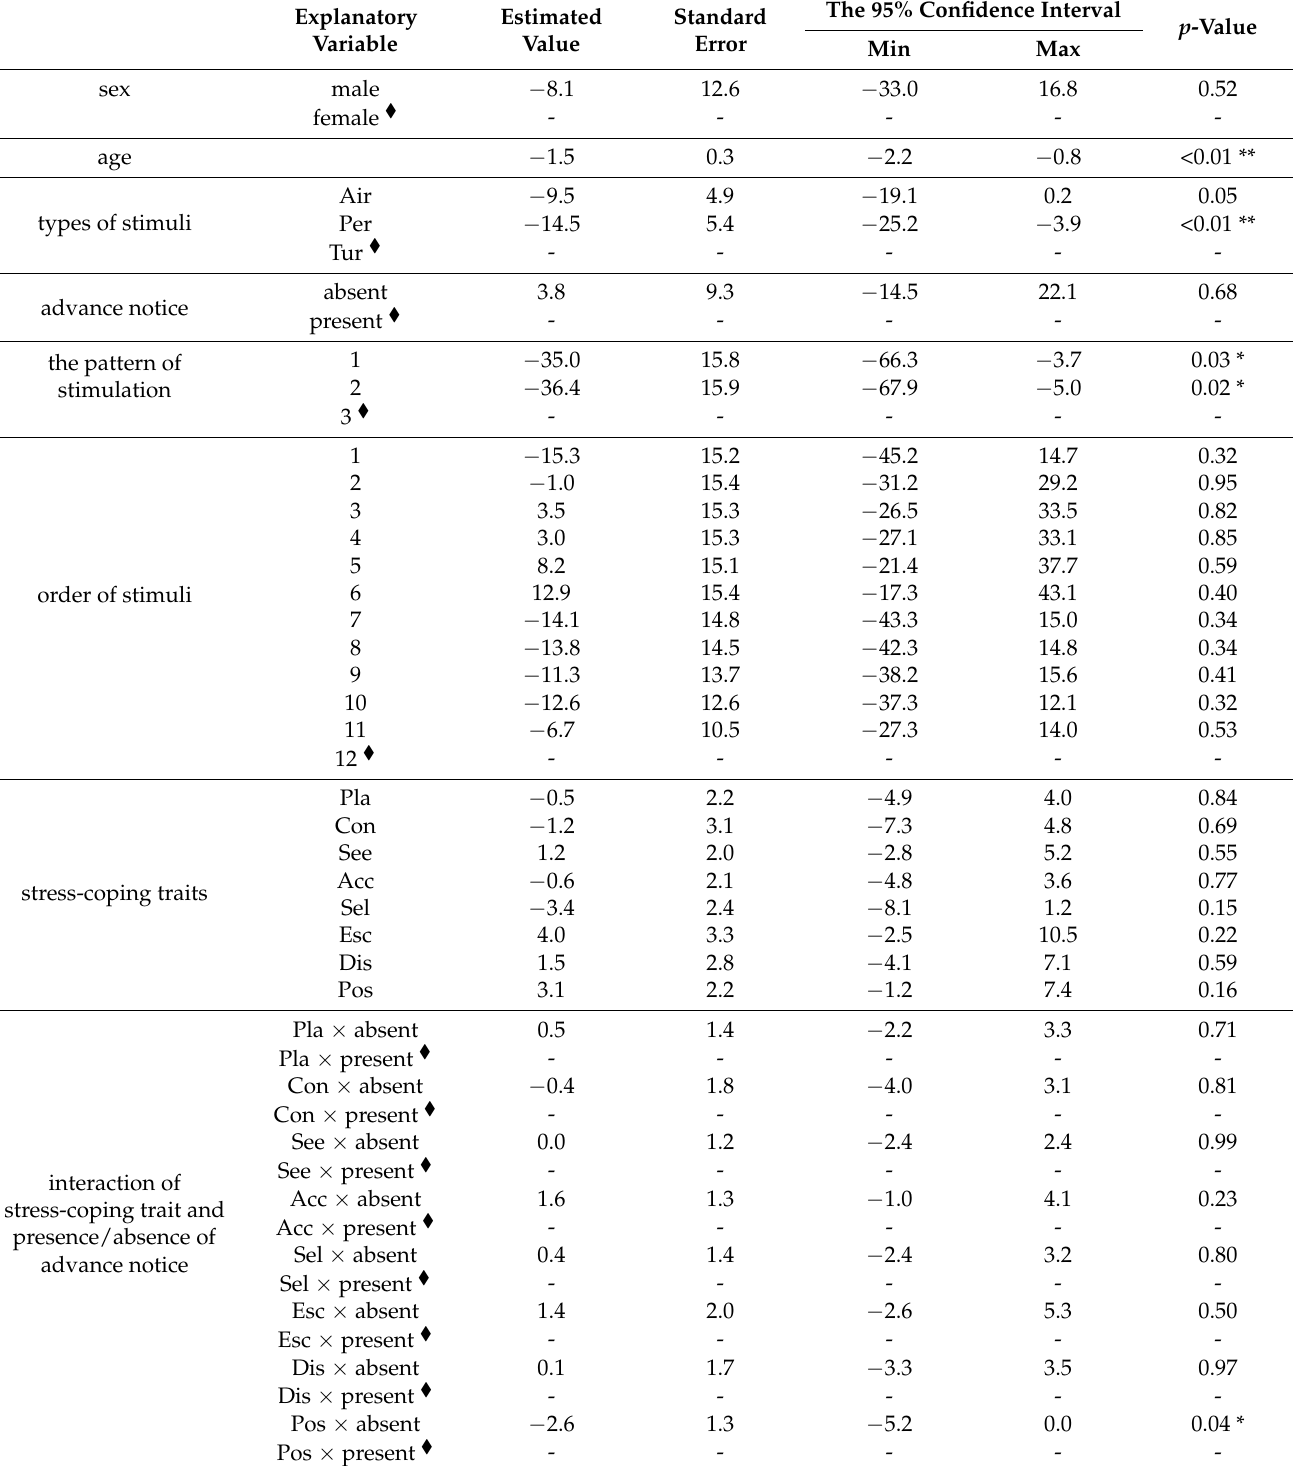
Table 4. The results of the analysis with PN including all the factors simultaneously.